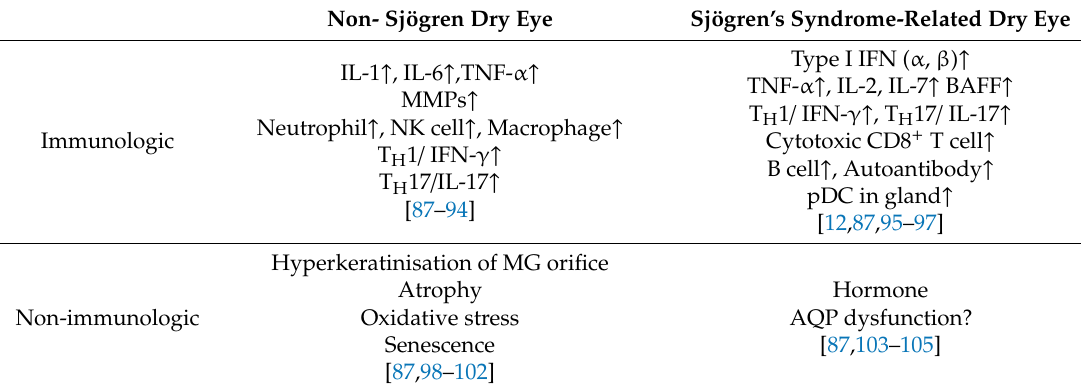
Table 3. Pathogenesis of non-Sjögren or Sjögren’s syndrome-related dry